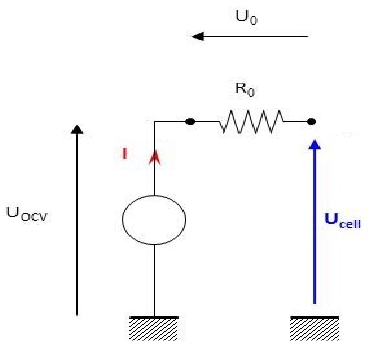
Figure 5. Diagram of the 0-order battery electrical model.